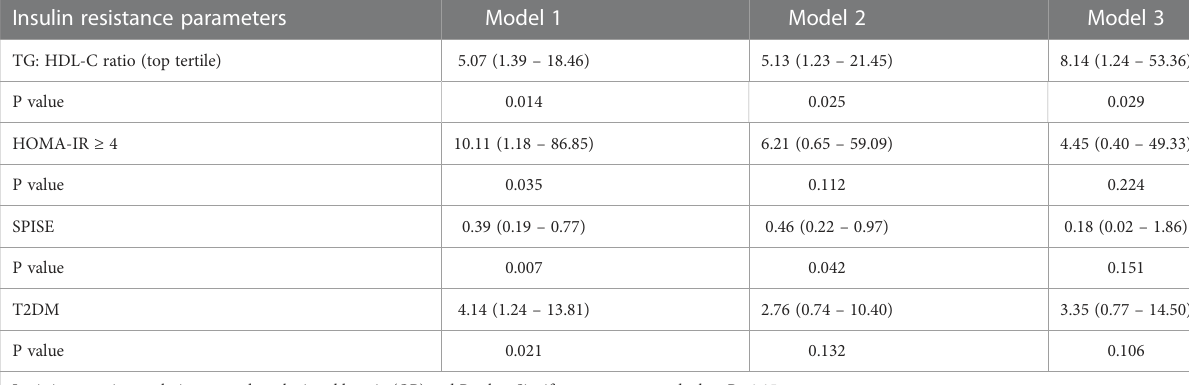
TABLE 3 Odds ratio of insulin resistance parameters and T2DM for liver fi brosis in overweight and obese children and adolescents. Insulin resistance